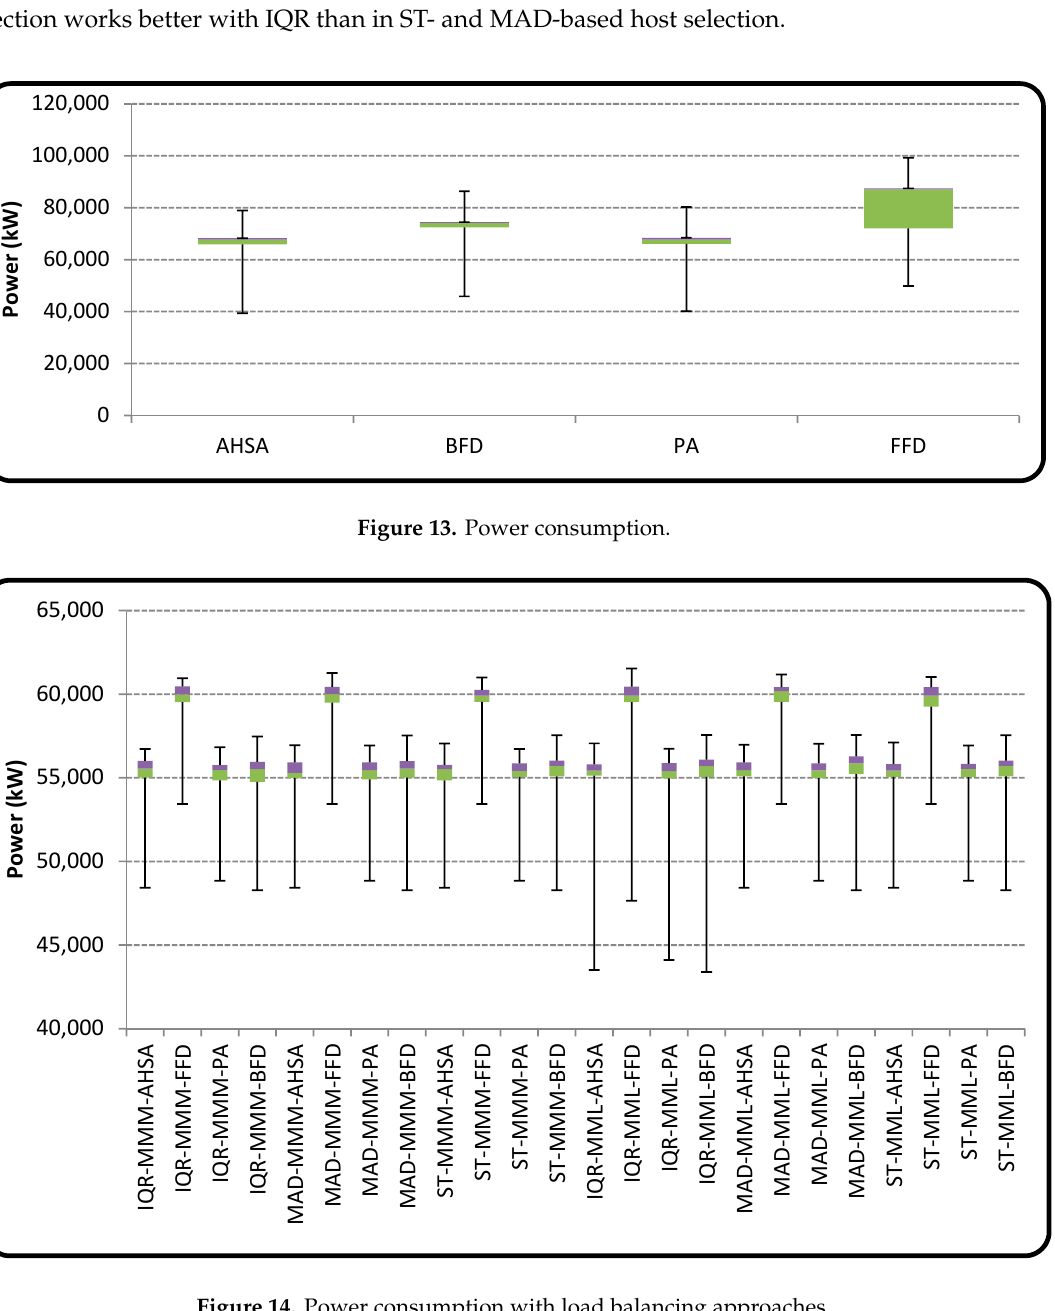
Figure 14. Power consumption with load balancing approaches.